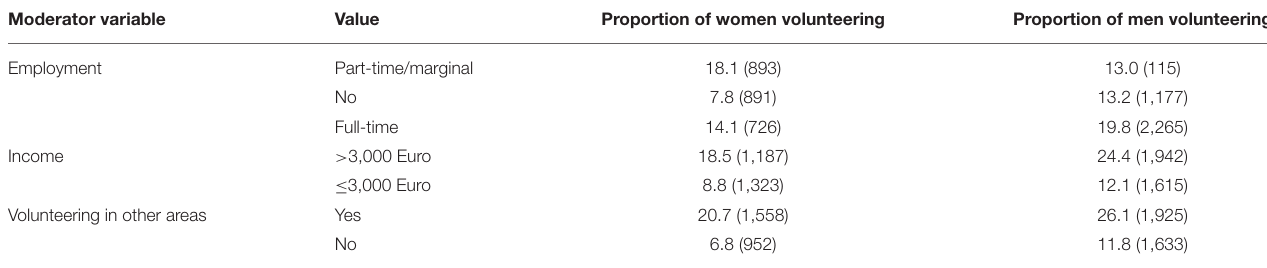
TABLE 7 | Proportion of volunteers by gender and different moderator